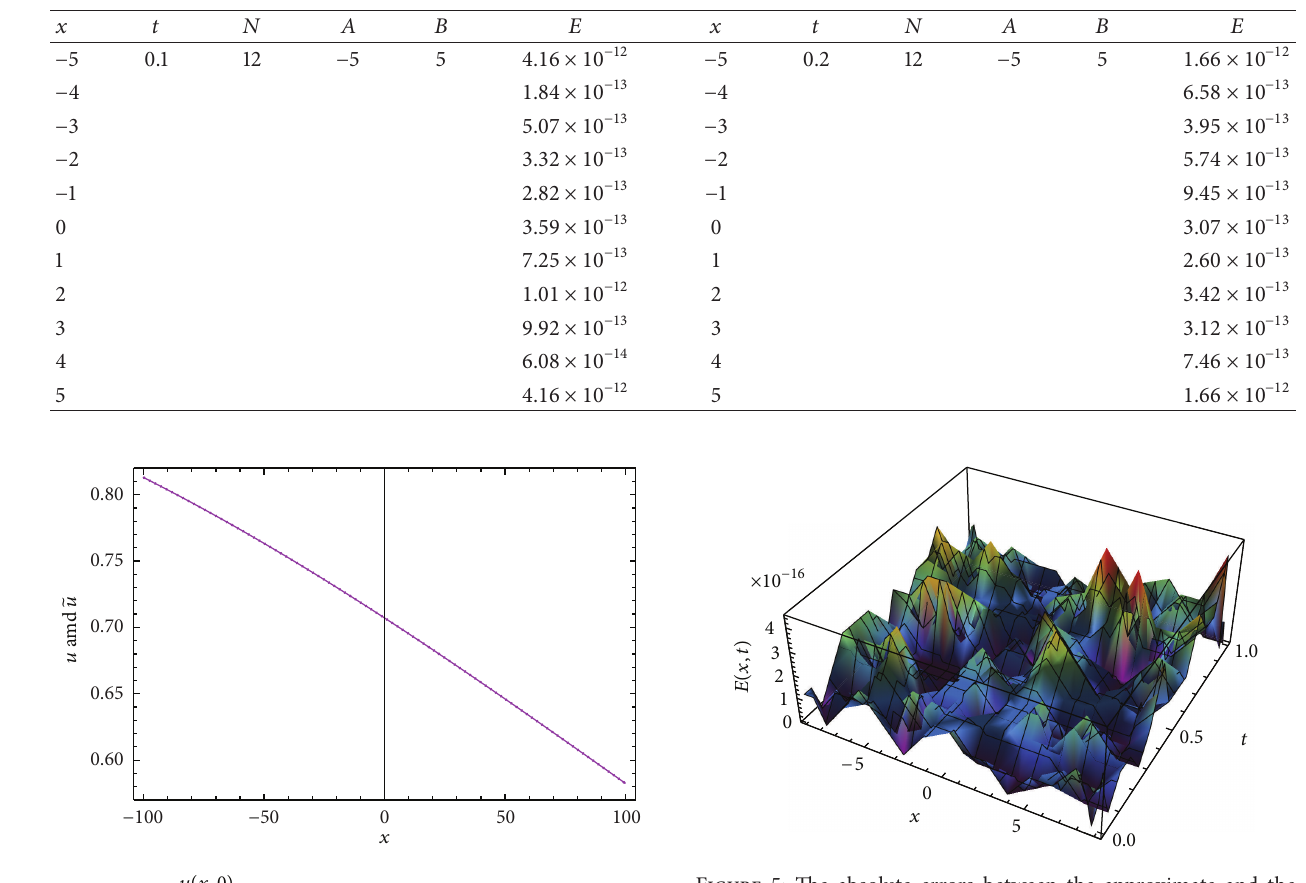
Figure 5: The absolute errors between the approximate and the exact solutions of problem (39) with 𝜃 = 𝜗 = 1/2 , 𝜆 1 = 0.01 , 𝑠 = 3 , and 𝑁 = 8